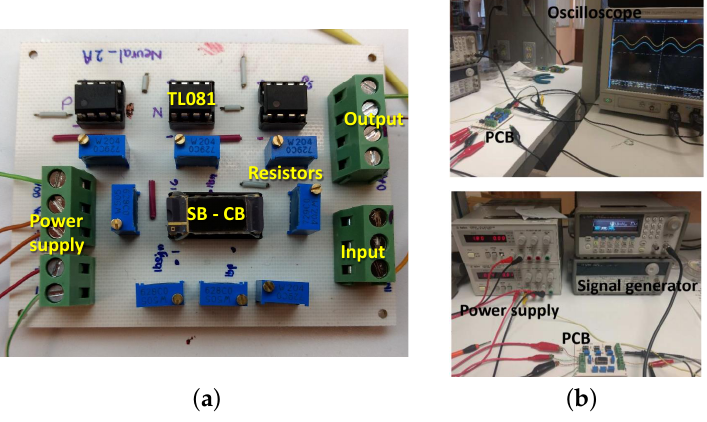
Figure 11. Photograph of the setup used for the characterization: ( a ) PCB; and ( b ) test